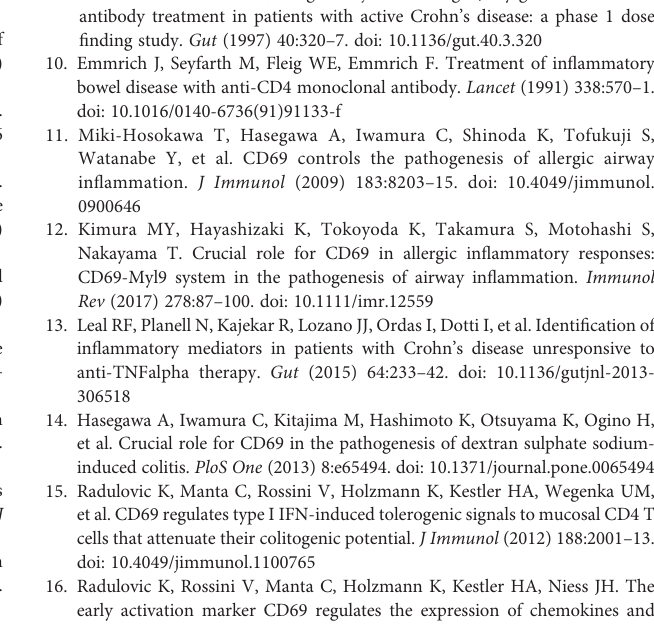
SUPPLEMENTARY FIGURE 1 | A schematic illustration of the DSS- induced colitis model. (A) Colitis was induced in female mice (age, 7 to 8 weeks) by the addition of 2% DSS to drinking water that had been puri fi ed by fi ltration. On days 5 and 7, mice were sacri fi ced for the indicated analyses. (B) The immunohistological analysis of the colon at 7 days after the administration of DSS, stained as indicated. CD69-expressing cells and Myl9/12-negative vessel. (C) Colitis was induced in female mice (age, 7 to 8 weeks) by adding 2% DSS to drinking water that had been puri fi ed by fi ltration. Anti-Myl9/12 mAb (114-2G9) or isotype Ab (104-6G4) was intraperitonially injected into the mice every 2 days from day 0 to day 12 (day